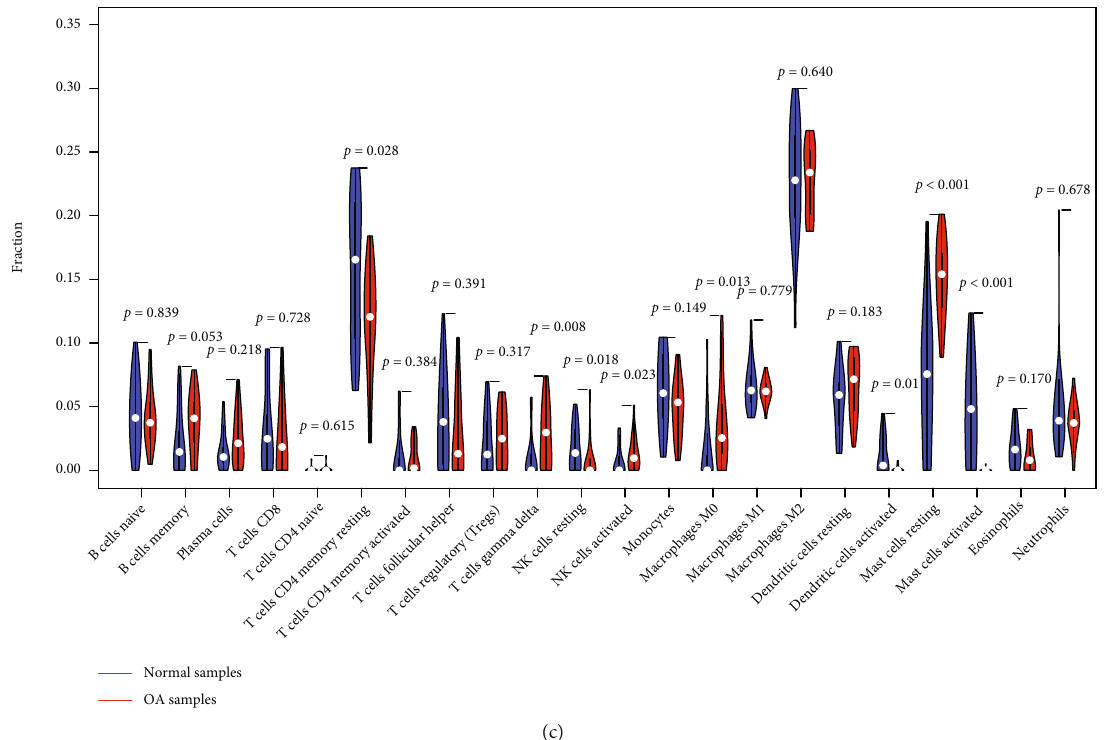
Figure 5: (a, b) The percentage of the 22 immunocytes identi fi ed via the CIBERSORT arithmetic. (c) The diversities in the architecture of immunocytes between healthy and OA